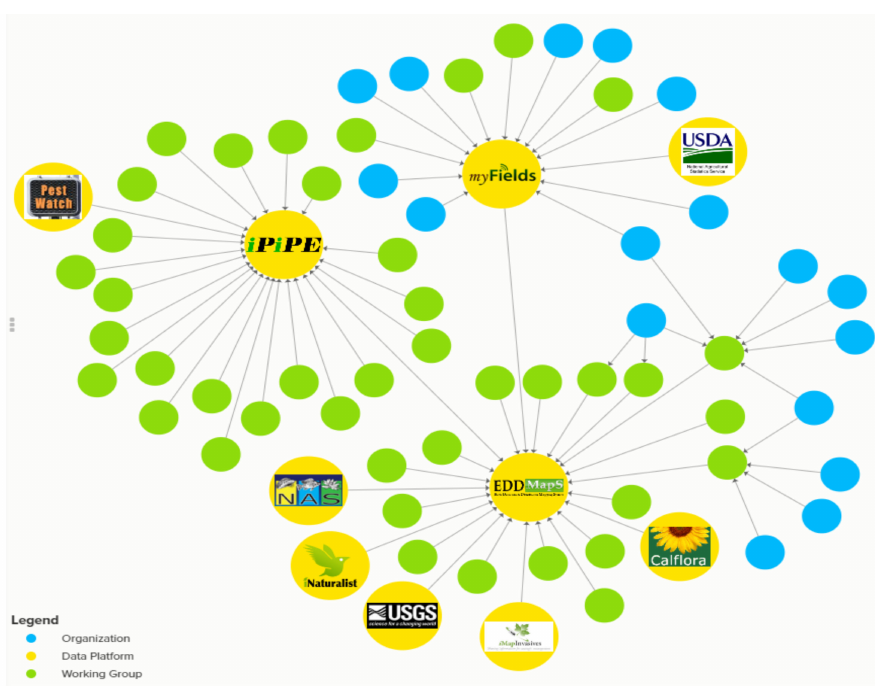
Figure 2. Illustration of the relationship of organizations (blue), working groups (green), and data platforms (yellow) that are currently engaged in data sharing to provide a more complete view of pests and invasive species. A full and current diagram of data sharers is available at https://kumu.io/IPMC/data-sharing-networks